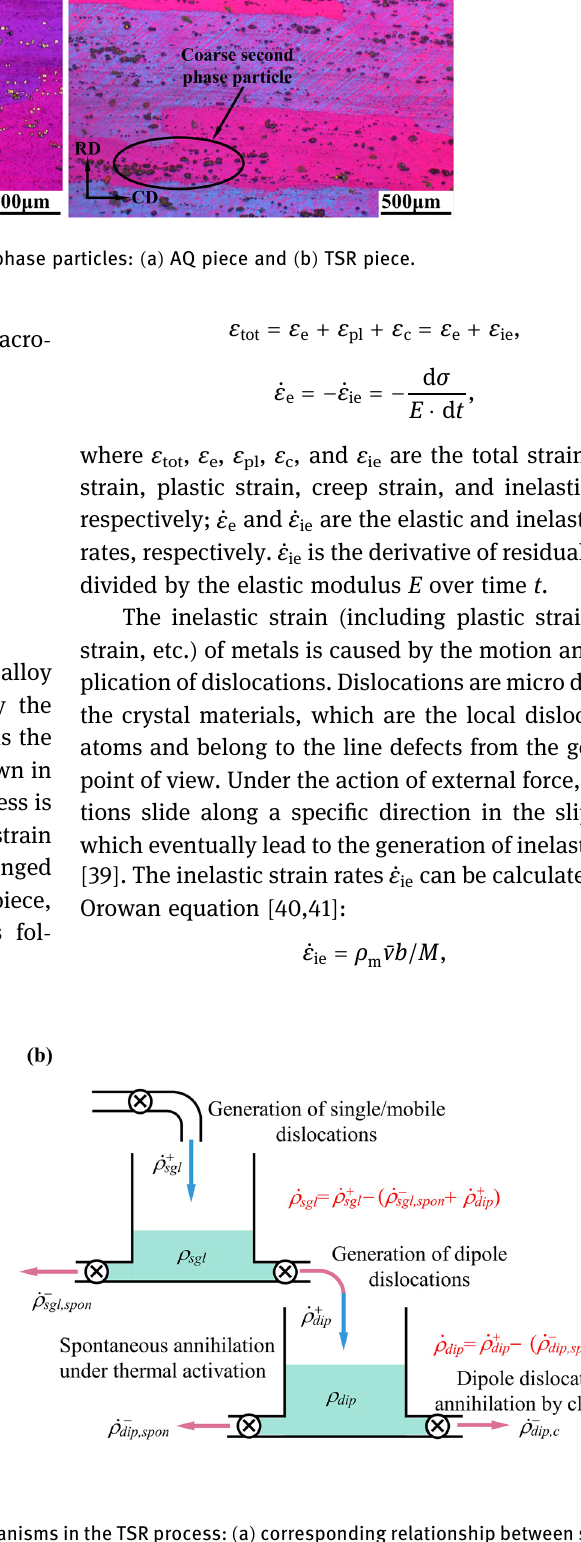
Figure 10: Schematic illustration of residual stress relief mechanisms in the TSR process: ( a ) corresponding relationship between stress and strain in the process of TSR and ( b ) evolution of dislocation